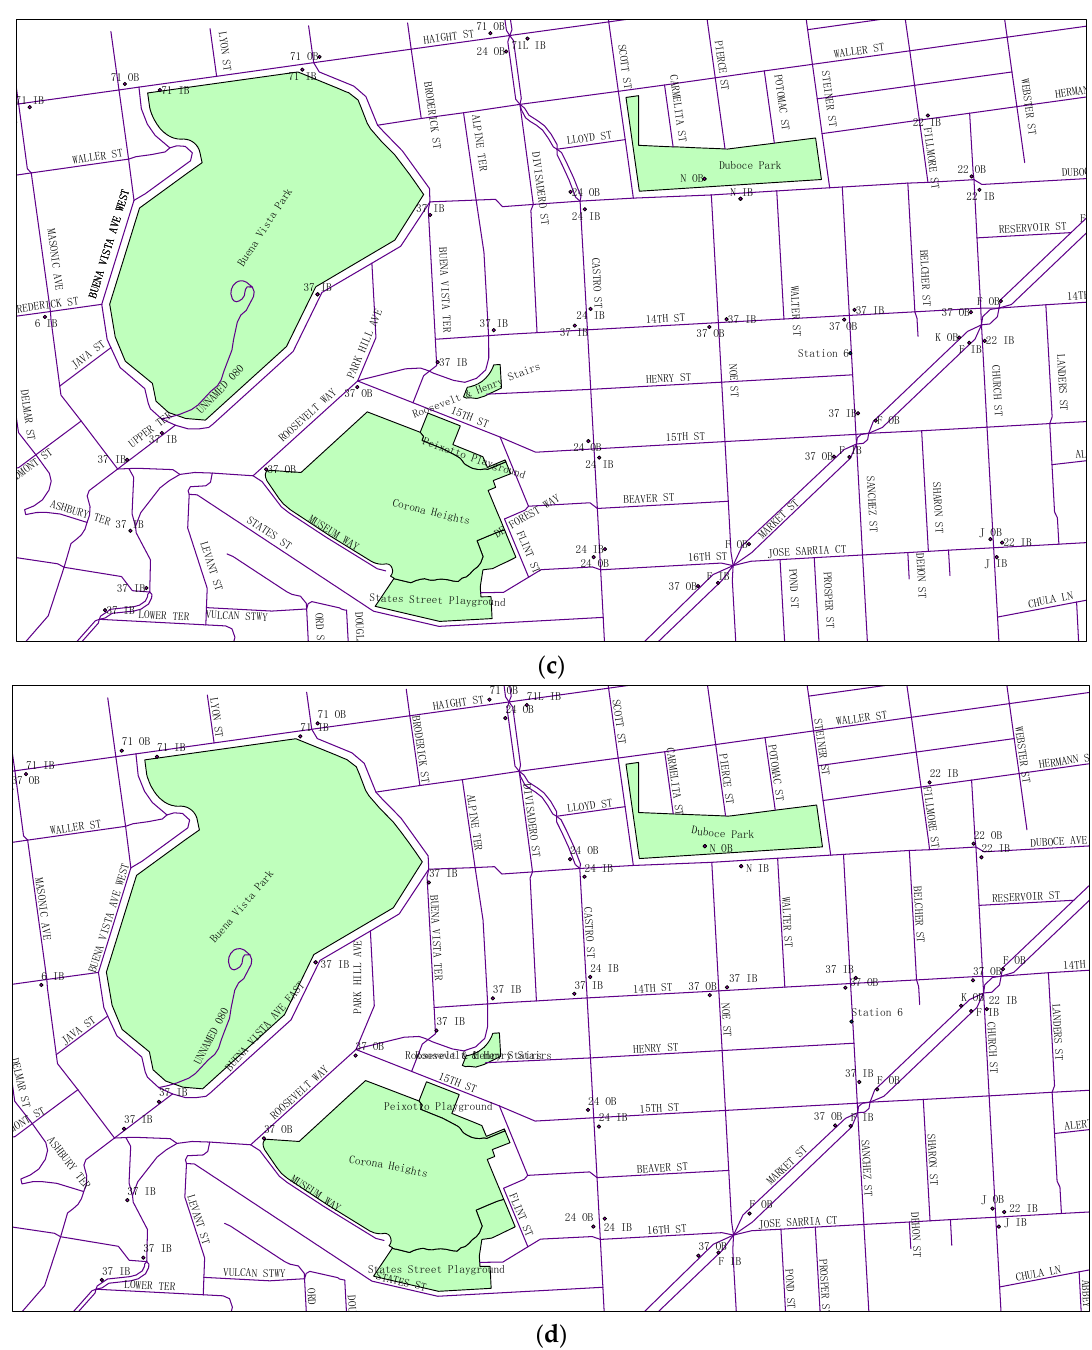
Figure 6. Map of near Buena Vista Park in San Francisco with labels generated by four approaches: ( a ) GA; ( b ) DDE; ( c ) DDEGA; and ( d ) Maplex. The convergence of the fitness function of the three algorithms is presented for the two case studies in Figure 7. In our experiment, the DDEGA displayed the best fitness scores for the optimal solution of label placement. Comparing the two convergence figures, we observed that new individuals were continuously generated through evolution of the population in DDEGA, and the algorithm converged quickly. When the population matured, it converged and gave the optimal solution. The early convergence of the GA was fast but the algorithm fell into a local minimum within 50 generations. It was difficult to produce new individuals with high fitness to obtain an optimal result in the end. The DDE exhibited continuous convergence; however, due to the large randomness of generation, the speed of convergence was relatively slow.